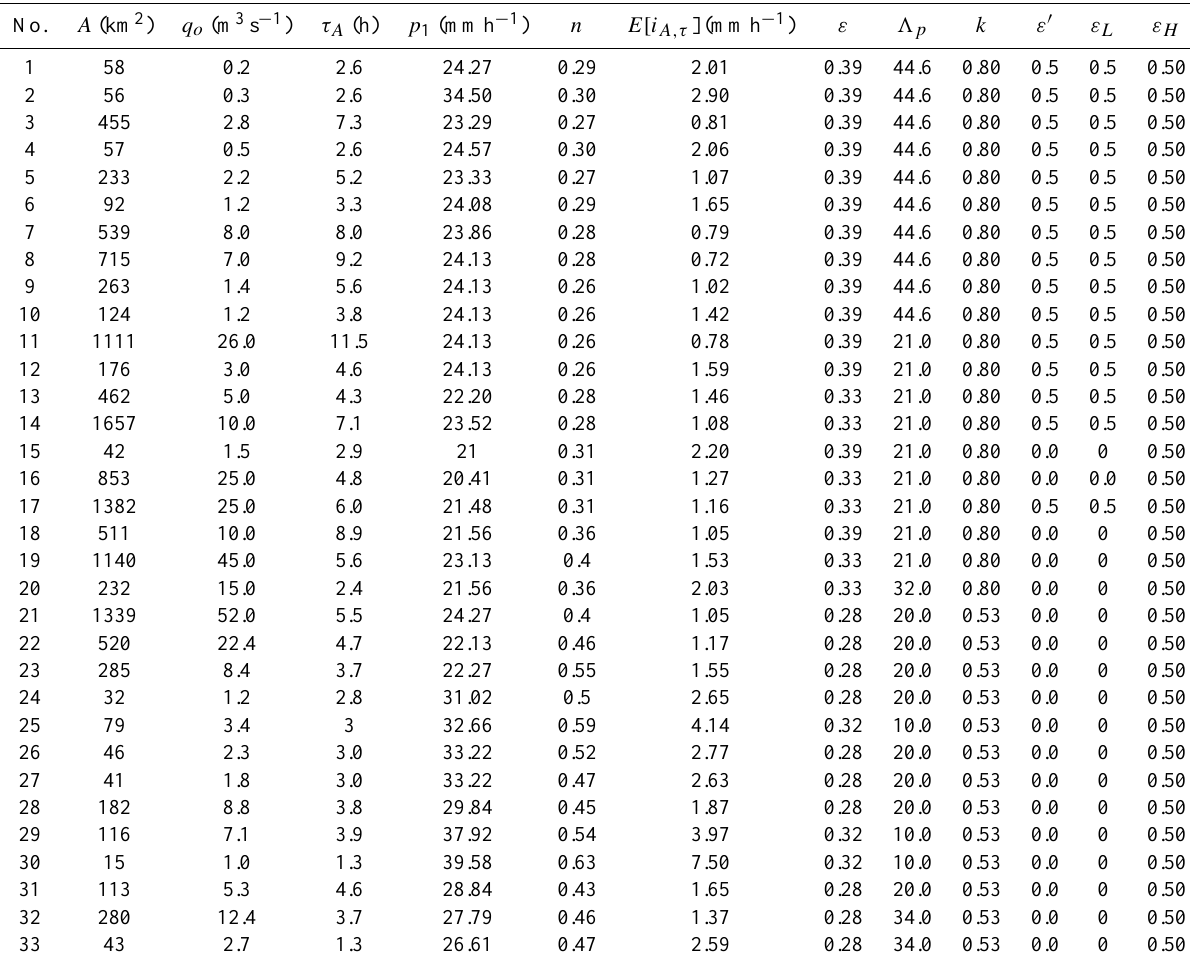
Table 3. Parameters of the IF and TCIF distributions based on information other than